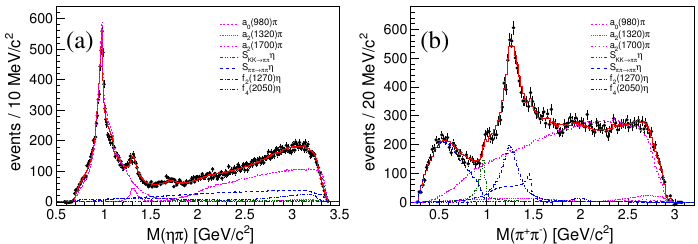
Figure 2. Projections in the (a) ηπ and (b) π + π − invariant mass from data, compared with our base-line fit (solid curve) and corresponding amplitudes (various dashed and dotted lines). Table 1. Fractional intensities F , significances and U.L. for exotic